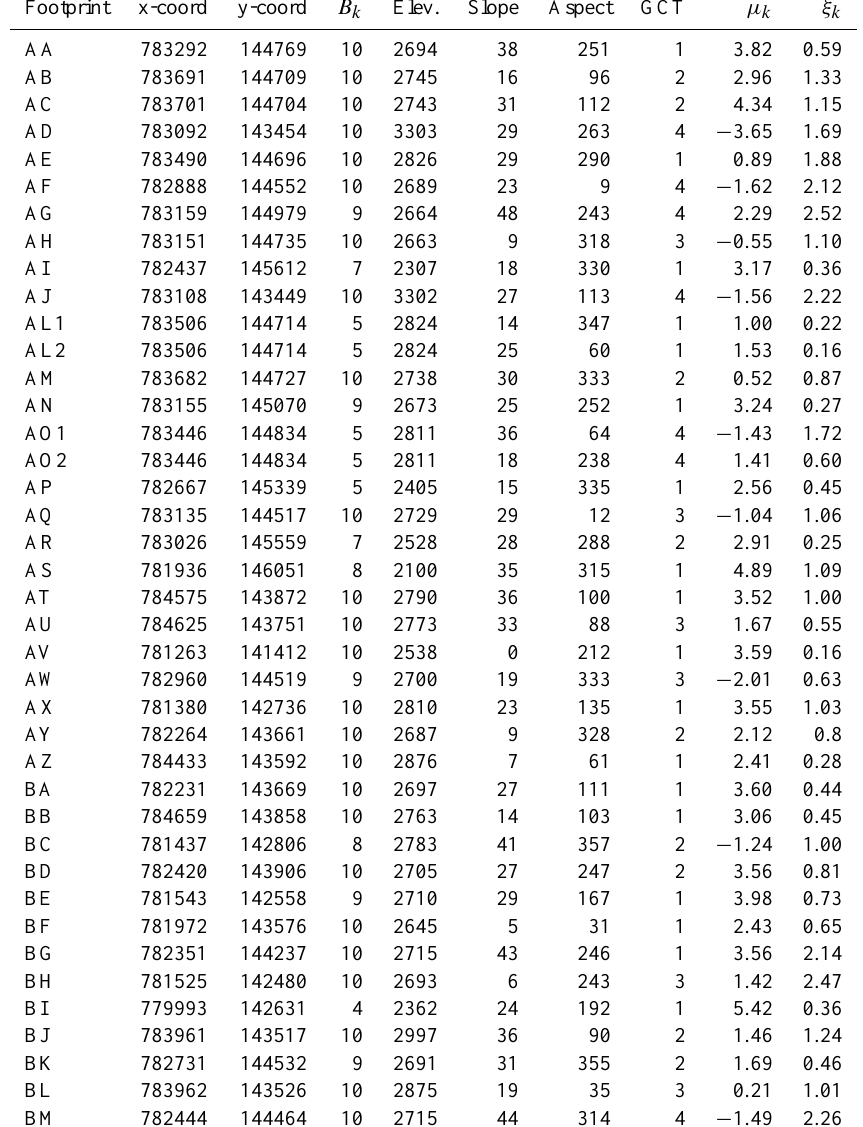
Table 1. Meta data of footprints. B k denotes the number of valid iButton measurements at footprint k . MAGST of footprint k is denoted by µ k (Eq. 1) and the variability of MAGST is ξ k (Eq. 2). Coordinates are given in the Swiss coordinate system CH1903. Elevation, slope and aspect are derived from a DEM with 25m resolution. Slope is given in degrees, as well as aspect counting from the north clockwise. GCT stands for ground cover type and classifies the footprints into four groups: group one is fine material often including organic material, group three is very coarse material such as the large boulders on the rock glaciers, and group two lies in between. Group four contains all